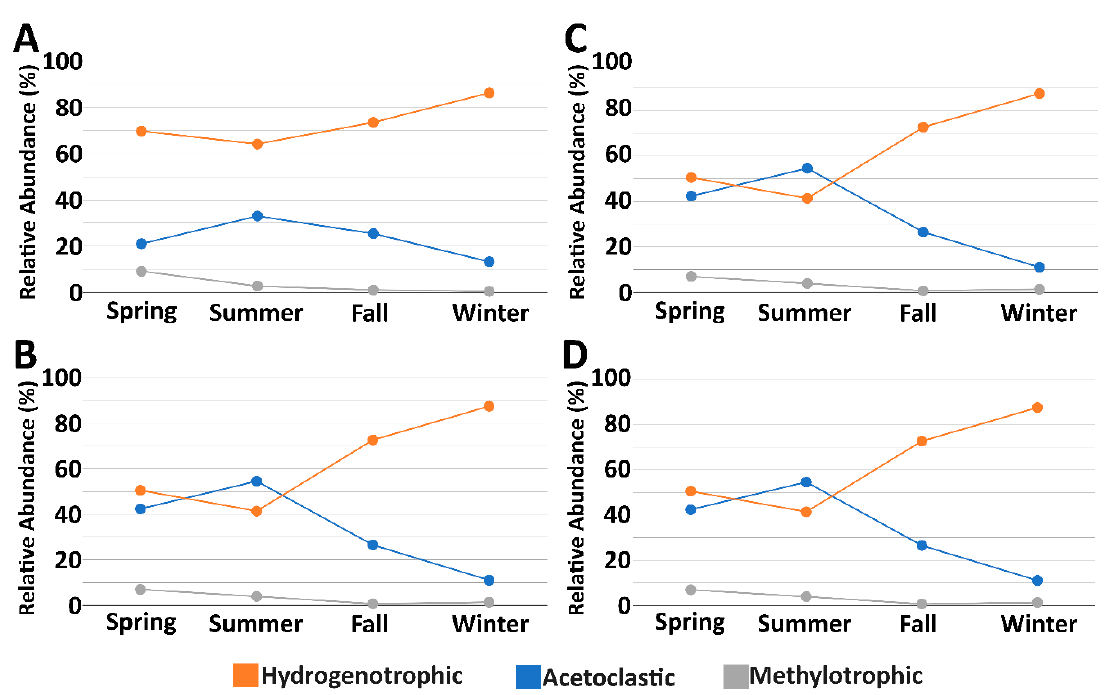
Figure 7. Relative abundance of classified operational taxonomic units (OTUs) potentially involved in methanogenic pathways. ( A ) Open Lagoon; ( B ) Open House; ( C ) Covered Lagoon; ( D ) Covered House.